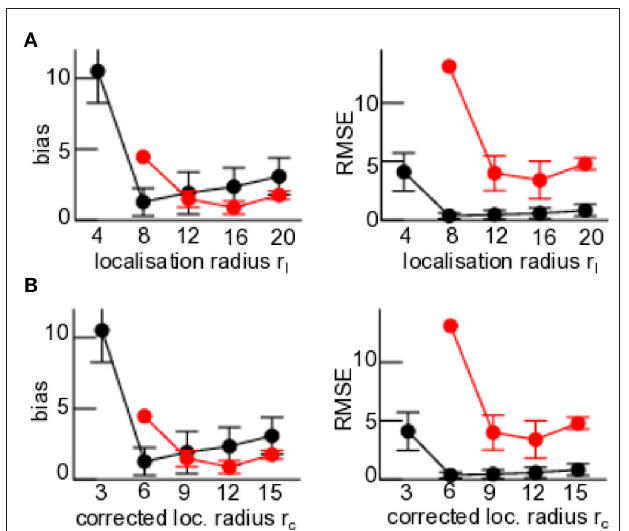
FIGURE 6 | First guess departure statistics of trials that do not reach the divergence threshold. Here r H localization radius r l . (B) Corrected localization radius r c with GC low statistical measures are based on 100